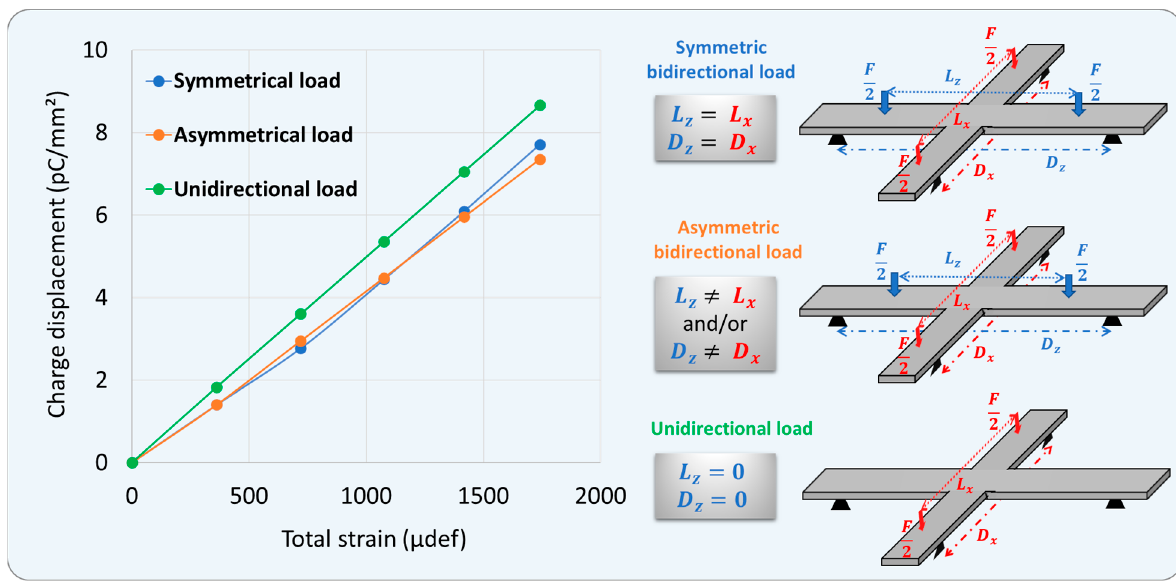
Figure 10. Charge displacement measured at the central electrode as a function of its total strain under three configurations of 4PB: unidirectional load, and bidirectional load with symmetry or asymmetry.